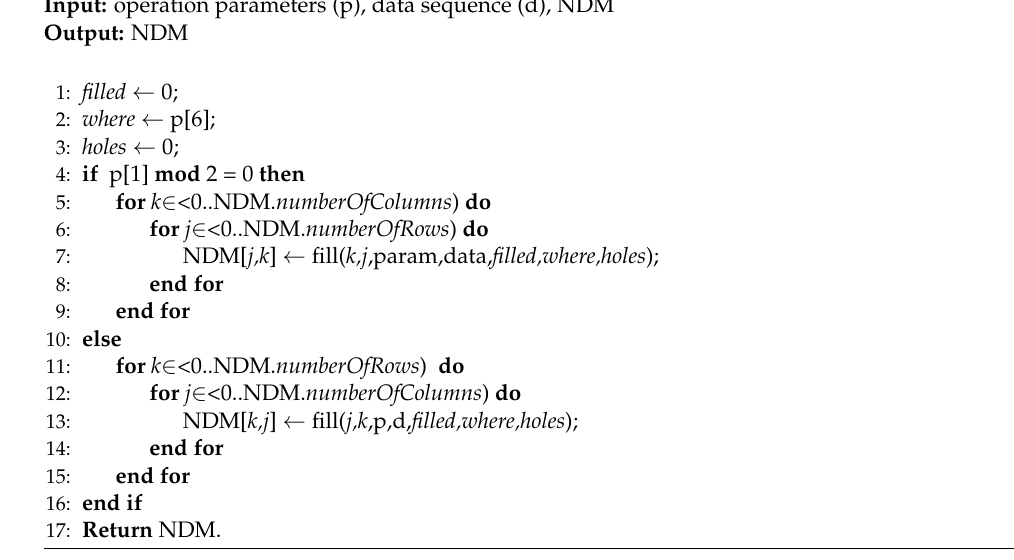
Algorithm 3 Pseudo-code of Oper2 [14].